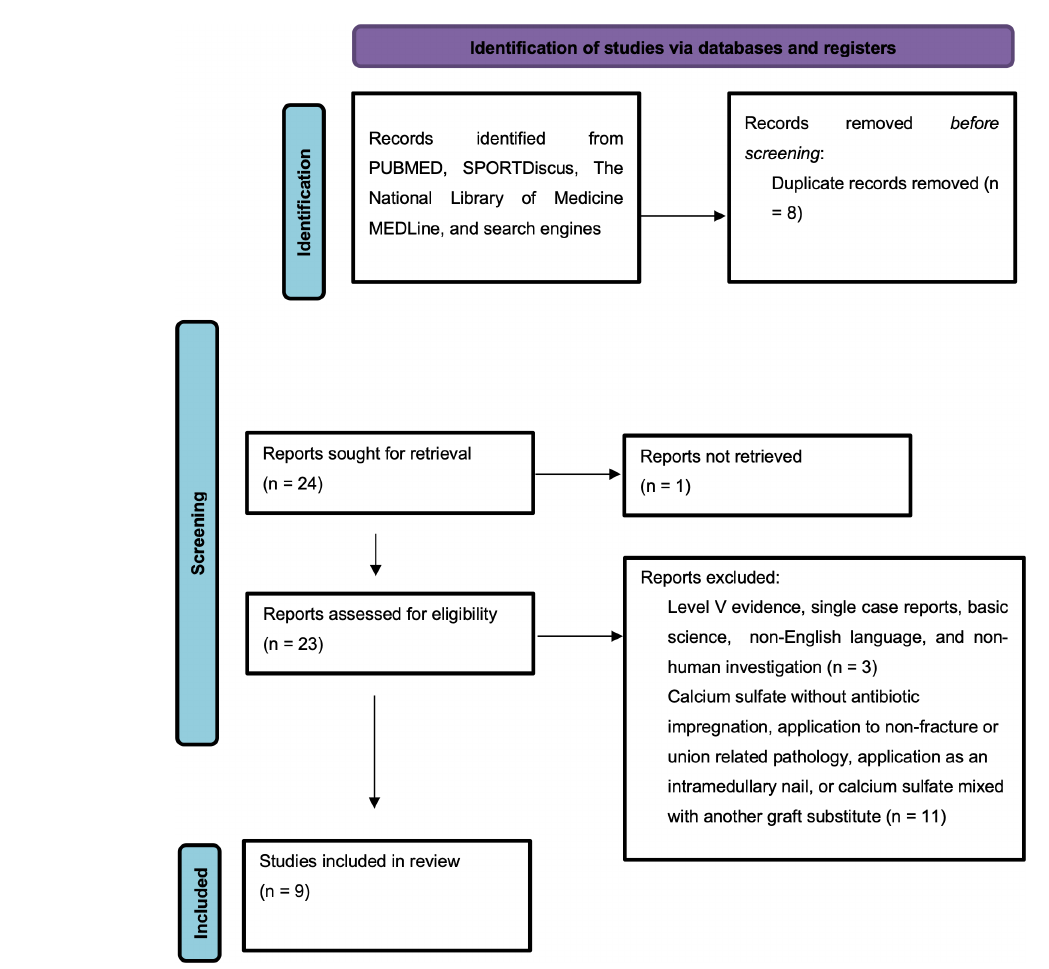
Figure 1. Flow chart describing the systematic